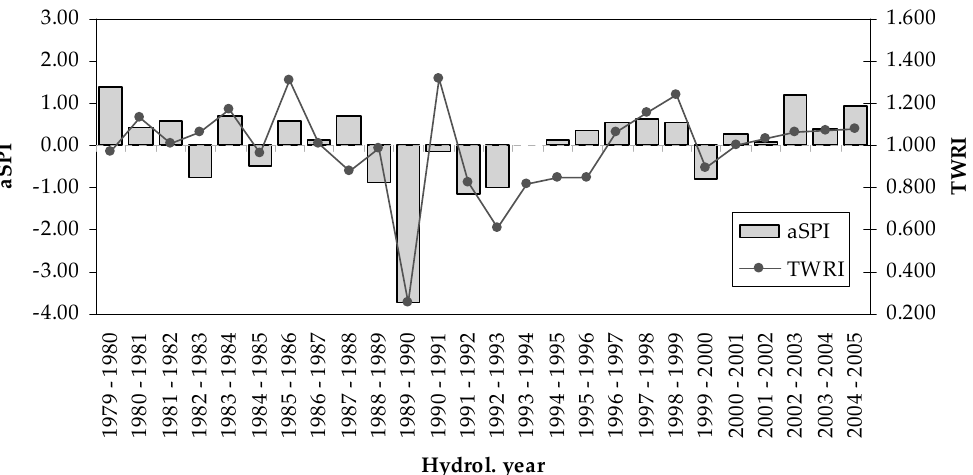
Figure 7. Comparison between TWRI and 6-month (October–March) aSPI for the period 1979–2005.